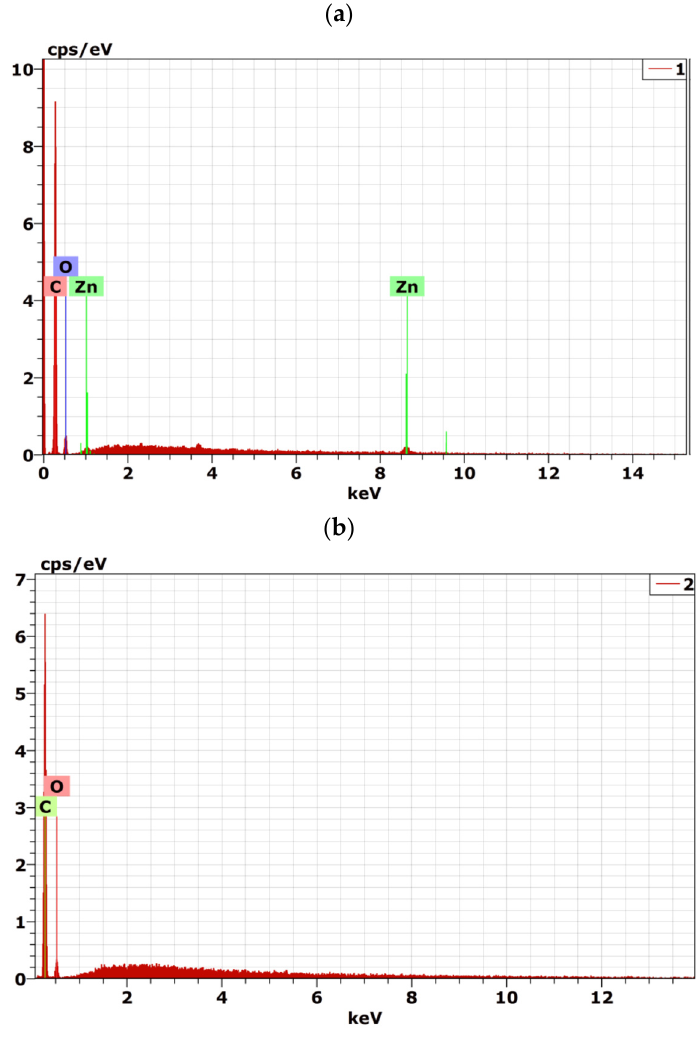
Figure 2. SEM-EDX spectra of ( a ) 3PMMA/7PEG/ZnO nanocomposite and ( b ) 3PMMA/7PEG blend. Table 2. Elemental composition of the polymer nanocomposites as detected by EDX.